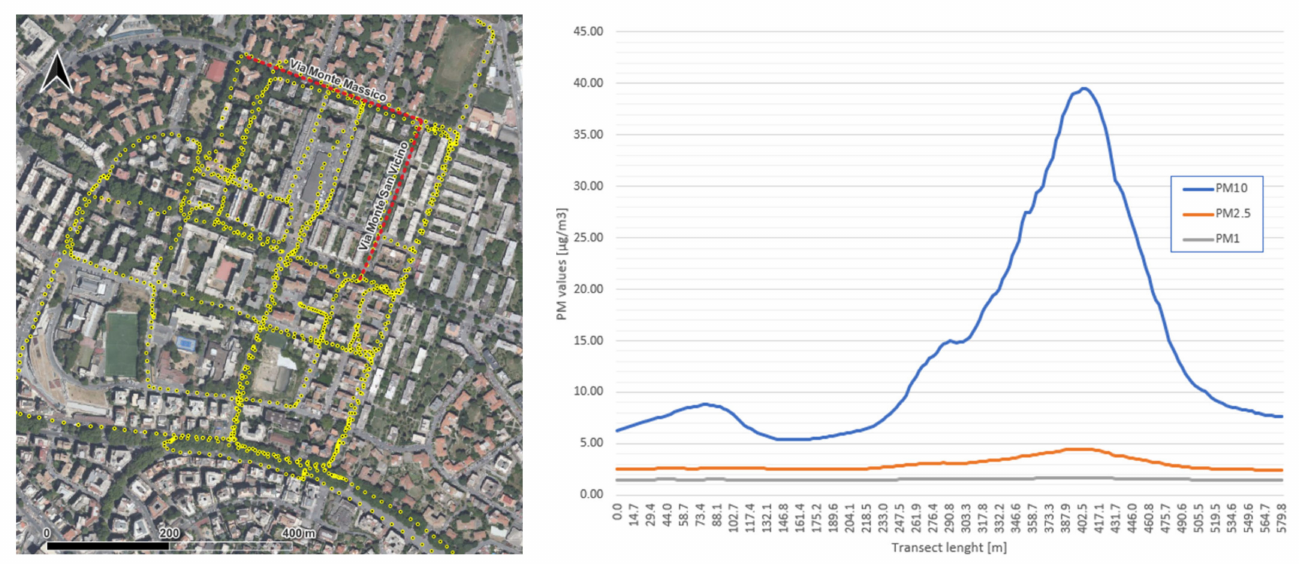
Figure 8. PM-1 (gray), PM-2.5 (orange), and PM-10 (blue) trends along transect 1 (Via Monte Massico– Via Monte S. Vicino, depicted in red on the map. PM acquisitions are depicted in yellow).